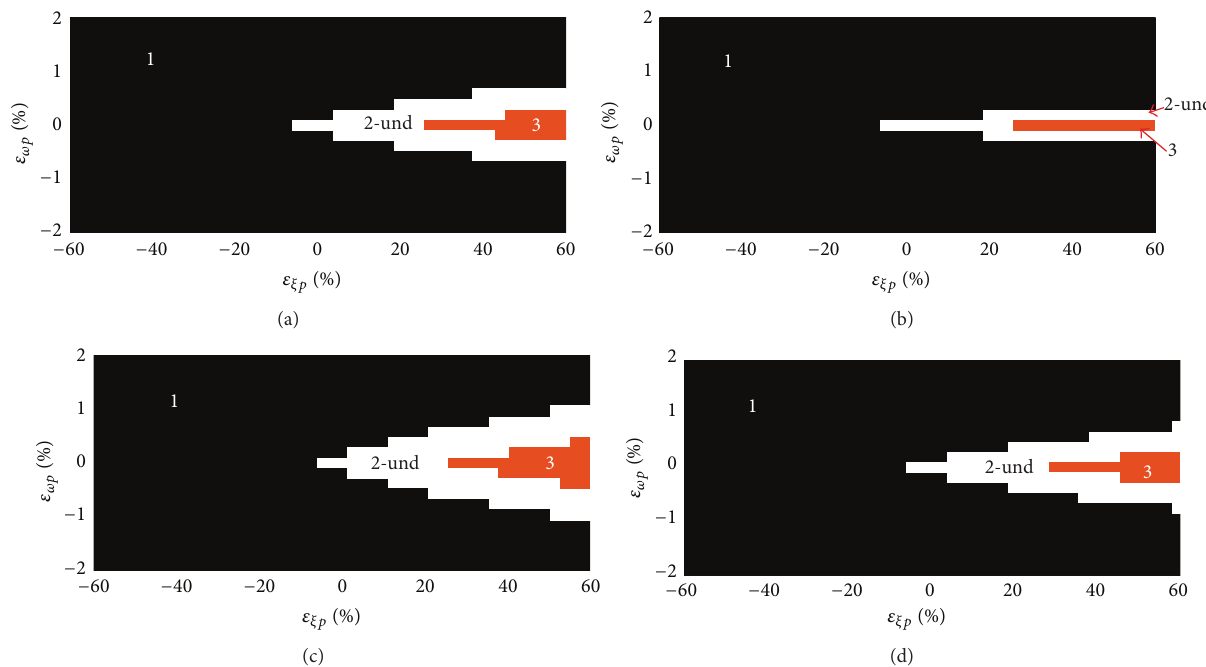
Figure 21: Maps showing the method featuring the best performance in terms of Perf |𝑇 𝑧𝑤 | max for a given bias on 𝜉 𝑝 and 𝜔 𝑝 . (a) Case 13 (refer to Table 5); (b) case 22; (c) case 16; and (d) case 14. The bias values on 𝜉 𝑝 were limited to ±60 %.